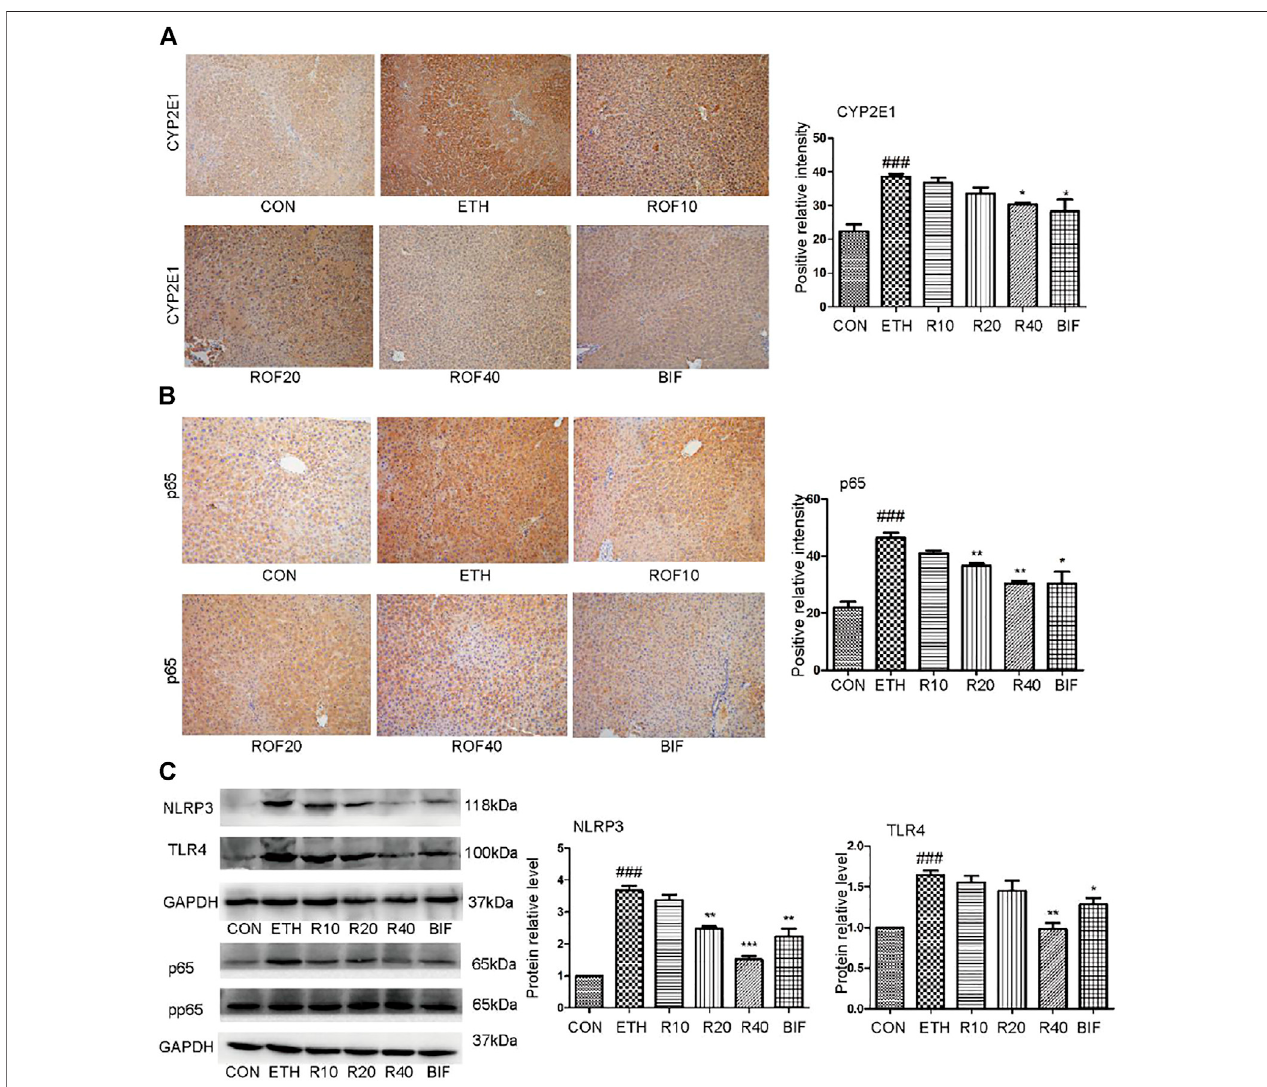
FIGURE 3 | Effect of ROF on CYP2E1 protein and TLR4/NF- κ B axis in mice. The expression of CYP2E1 (A) and p65 (B) in the liver tissues detected by immunohistochemical staining (×200 magni fi cation ). The protein levels of NLRP3, TLR4, and pp65 were detected by Western blotting (C) . Mean ± SEM ( n = 3). * p < 0.05, ** p < 0.01 and *** p < 0.001 vs. the ETH group. ## p < 0.01 vs. the CON